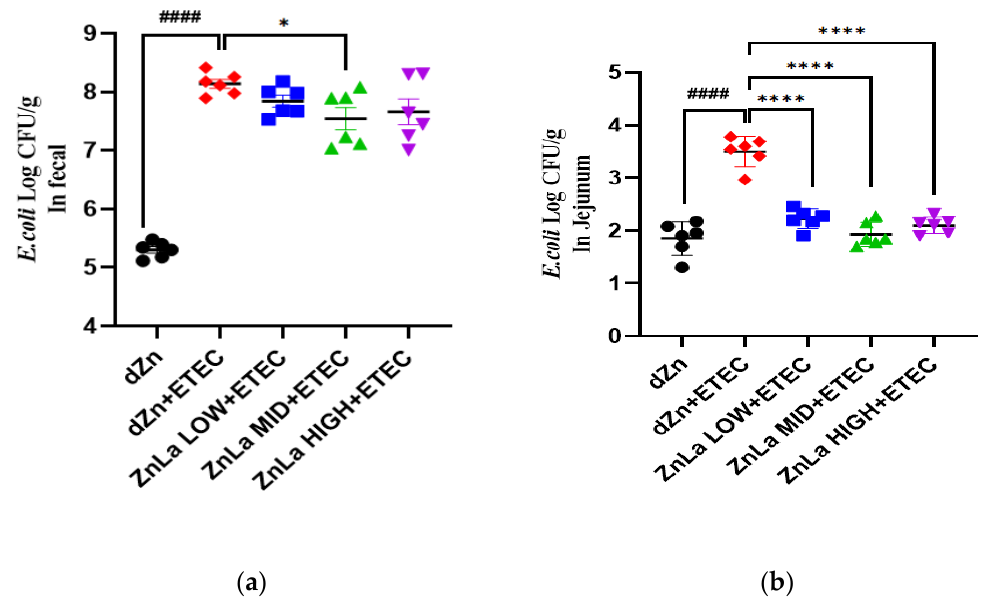
Figure 7. Effect of ZnLa on the content of ETEC in the feces and jejunum with ETEC infection mice.